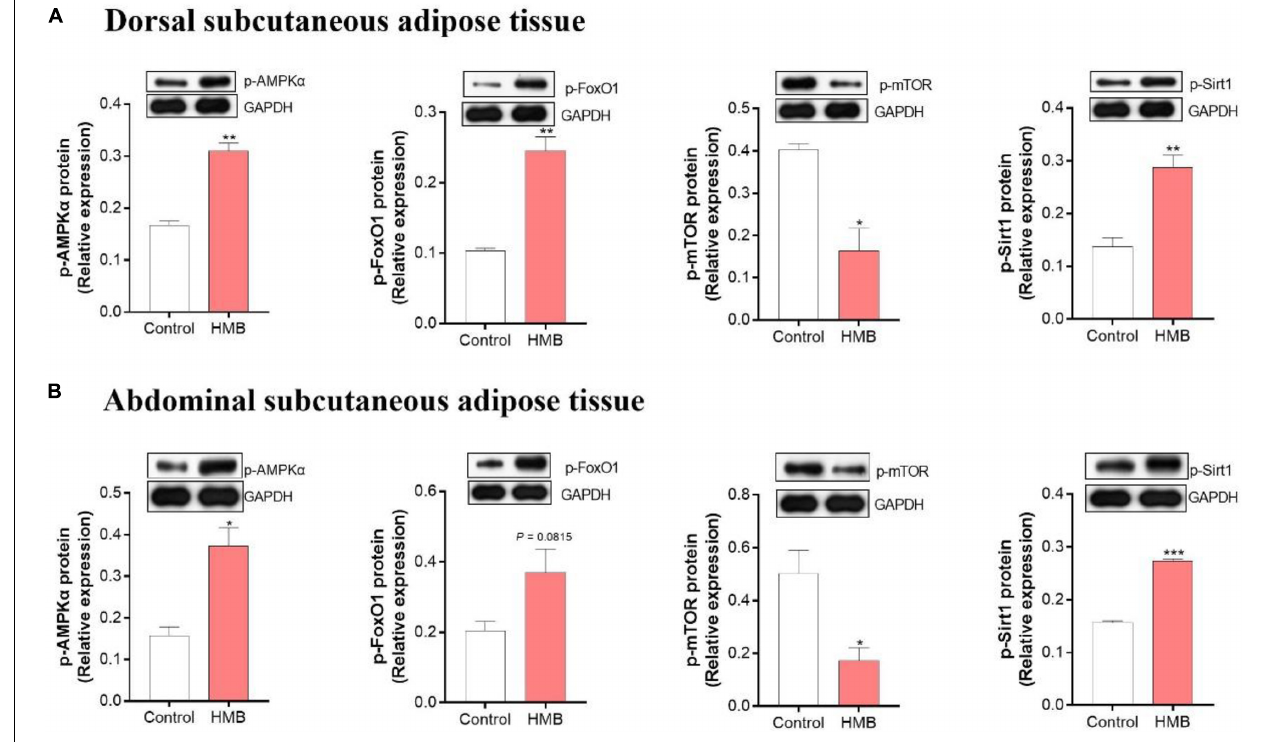
FIGURE 6 | The expression of phosphorylation (p)-AMPK α , FoxO1, mTOR and Sirt1 in DSA (A) and ASA (B) of Bama Xiang mini-pigs fed diets with 0.13% HMB-Ca. Data are presented as mean ± SEM ( n = 8). * P < 0.05, ** P < 0.01, *** P < 0.001. AMPK, AMP-activated protein kinase; FoxO1, forkhead box O1; mTOR, mammalian target of rapamycin; Sirt1, silent information regulator 2 related enzyme